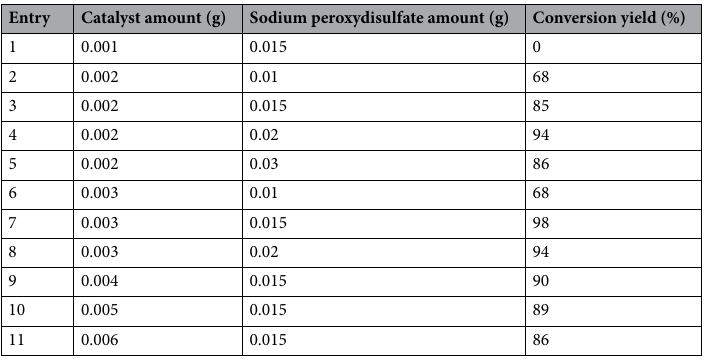
Table 1. Influence of the amount of catalyst and sodium peroxydisulfate on the degradation of 4-NP after 3 h at 25 °C.